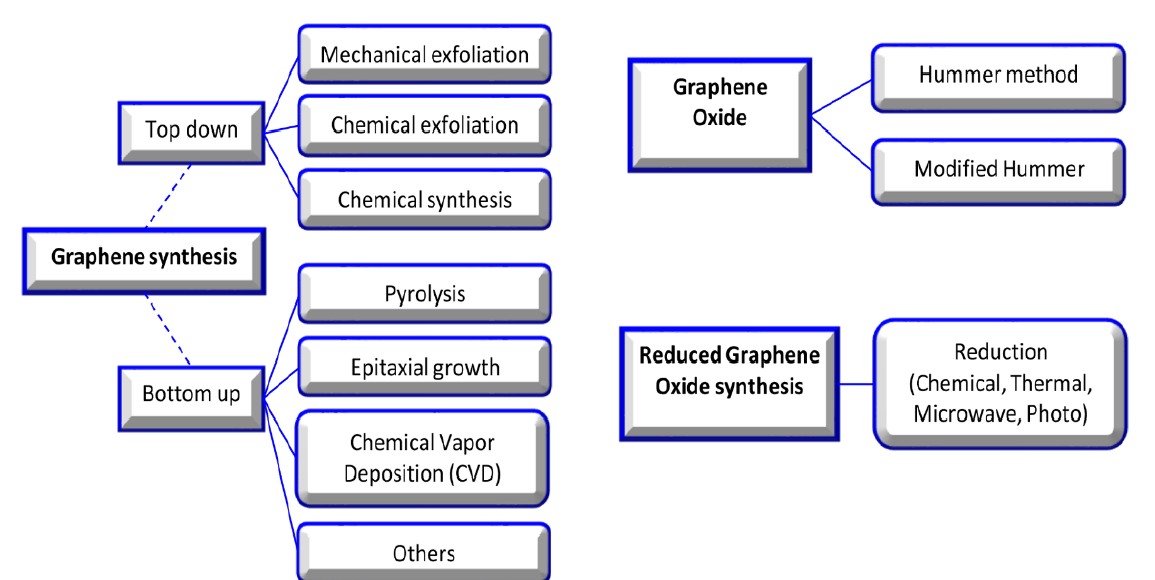
Figure 2. Graphene, graphene oxide, and reduced graphene oxide synthesis methods [9].